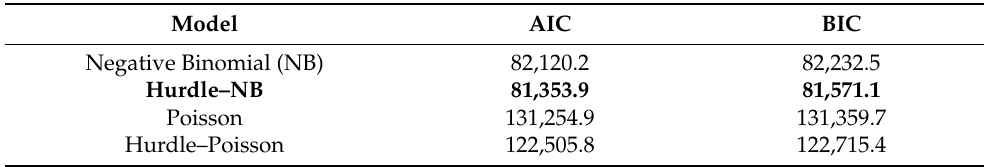
Table 5. Model comparison using AIC/BIC.